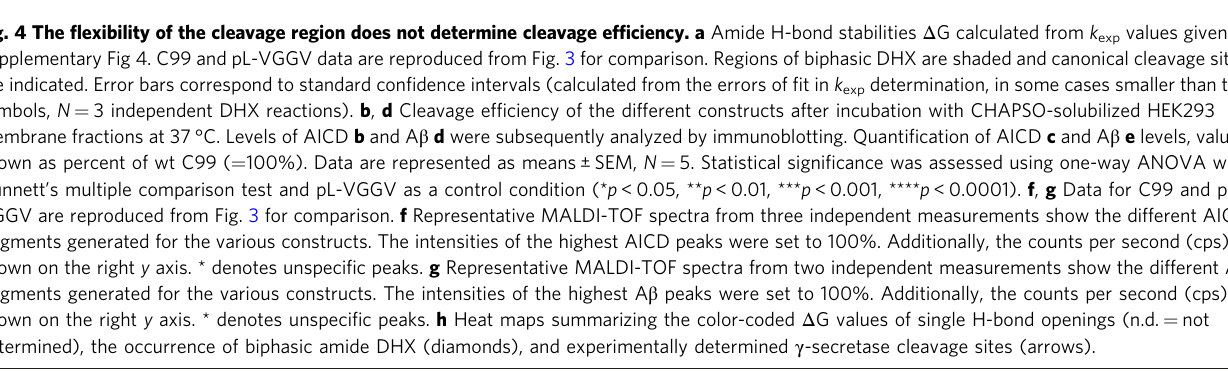
Fig. 4 The fl exibility of the cleavage region does not determine cleavage ef fi ciency. a Amide H-bond stabilities Δ G calculated from k exp values given in Supplementary Fig 4. C99 and pL-VGGV data are reproduced from Fig. 3 for comparison. Regions of biphasic DHX are shaded and canonical cleavage sites are indicated. Error bars correspond to standard con fi dence intervals (calculated from the errors of fi t in k exp determination, in some cases smaller than the symbols, N = 3 independent DHX reactions). b , d Cleavage ef fi ciency of the different constructs after incubation with CHAPSO-solubilized HEK293 membrane fractions at 37 °C. Levels of AICD b and A β d were subsequently analyzed by immunoblotting. Quanti fi cation of AICD c and A β e levels, values shown as percent of wt C99 ( = 100%). Data are represented as means ± SEM, N = 5. Statistical signi fi cance was assessed using one-way ANOVA with Dunnett ’ s multiple comparison test and pL-VGGV as a control condition (* p < 0.05, ** p < 0.01, *** p < 0.001, **** p < 0.0001). f , g Data for C99 and pL- VGGV are reproduced from Fig. 3 for comparison. f Representative MALDI-TOF spectra from three independent measurements show the different AICD fragments generated for the various constructs. The intensities of the highest AICD peaks were set to 100%. Additionally, the counts per second (cps) is shown on the right y axis. * denotes unspeci fi c peaks. g Representative MALDI-TOF spectra from two independent measurements show the different A β fragments generated for the various constructs. The intensities of the highest A β peaks were set to 100%. Additionally, the counts per second (cps) is shown on the right y axis. * denotes unspeci fi c peaks. h Heat maps summarizing the color-coded Δ G values of single H-bond openings (n.d. = not determined), the occurrence of biphasic amide DHX (diamonds), and experimentally determined γ -secretase cleavage sites